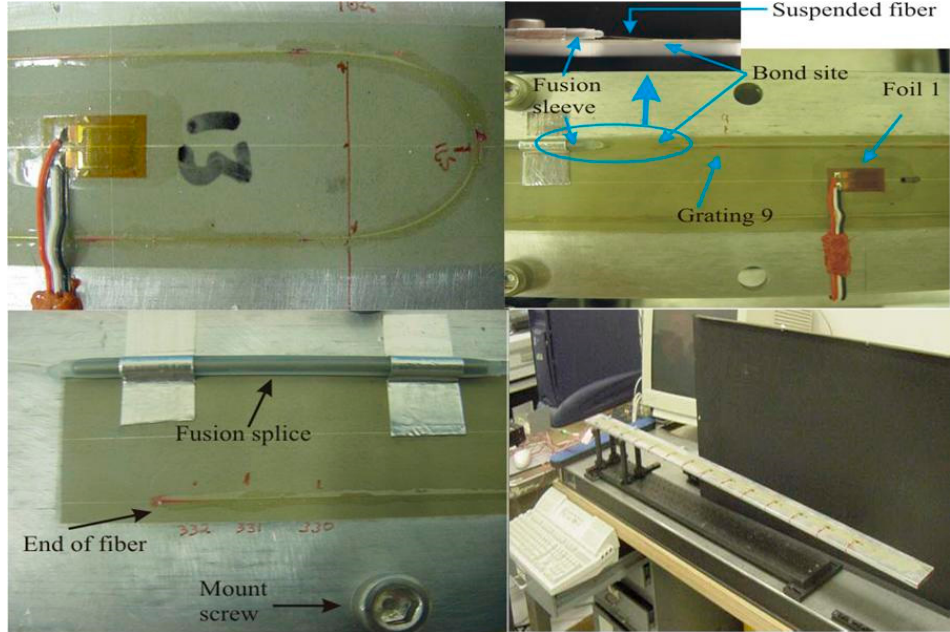
Figure 18. Experimental equipment and FOSS System Layout Design [79].